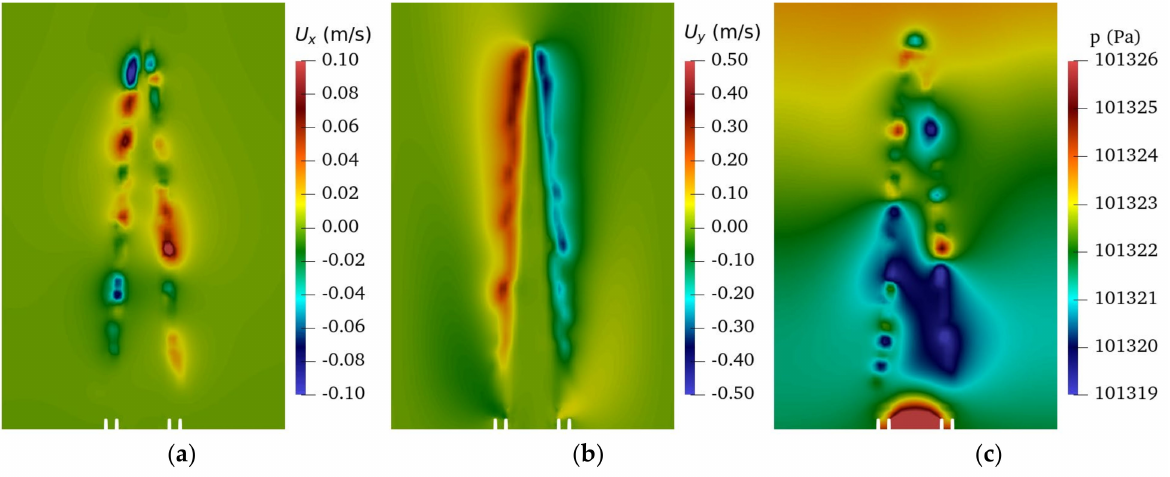
Figure 7. The y–z plane cut of the LES simulation for ( a ) x-component velocity, ( b ) y-component velocity, and ( c )